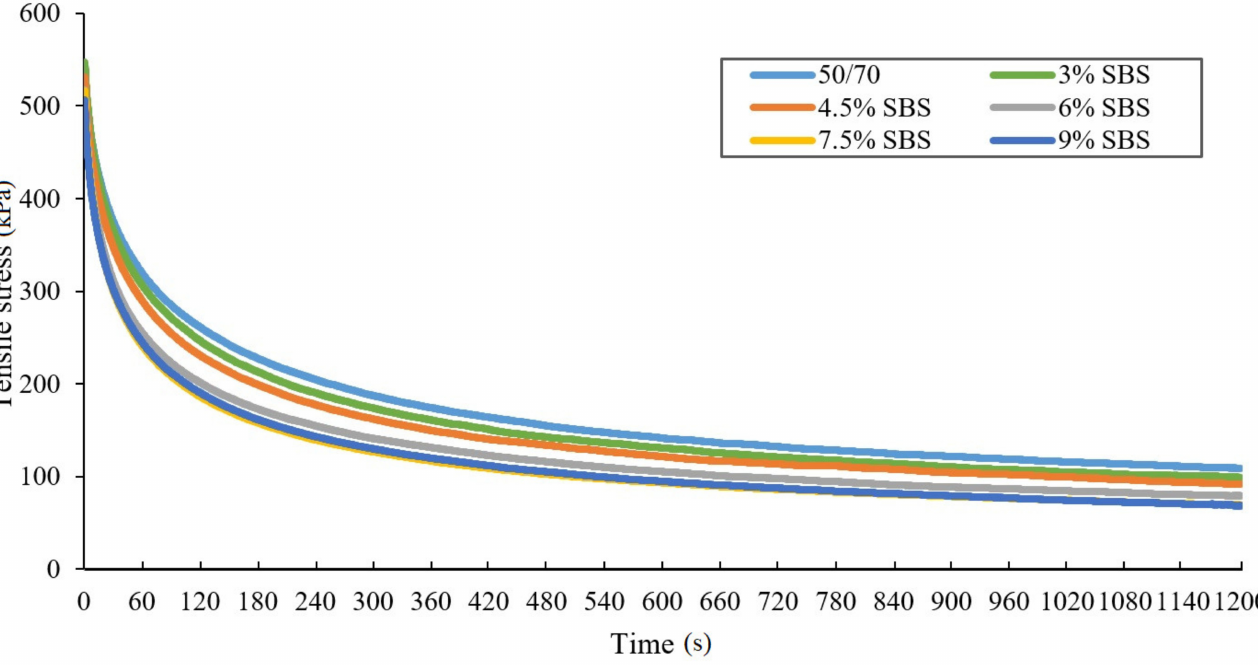
Figure 7. Relaxation curves of unaged bituminous binders obtained from the force-ductility-relaxation test conducted at − 16 ◦